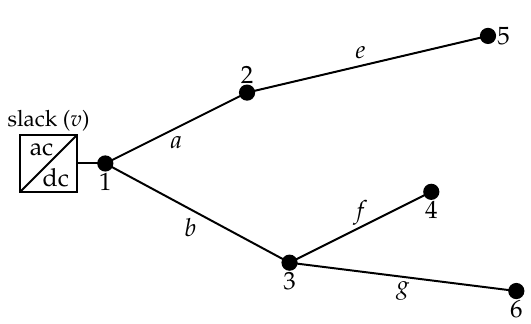
Figure A2. Selected configuration for the 6-nodes test